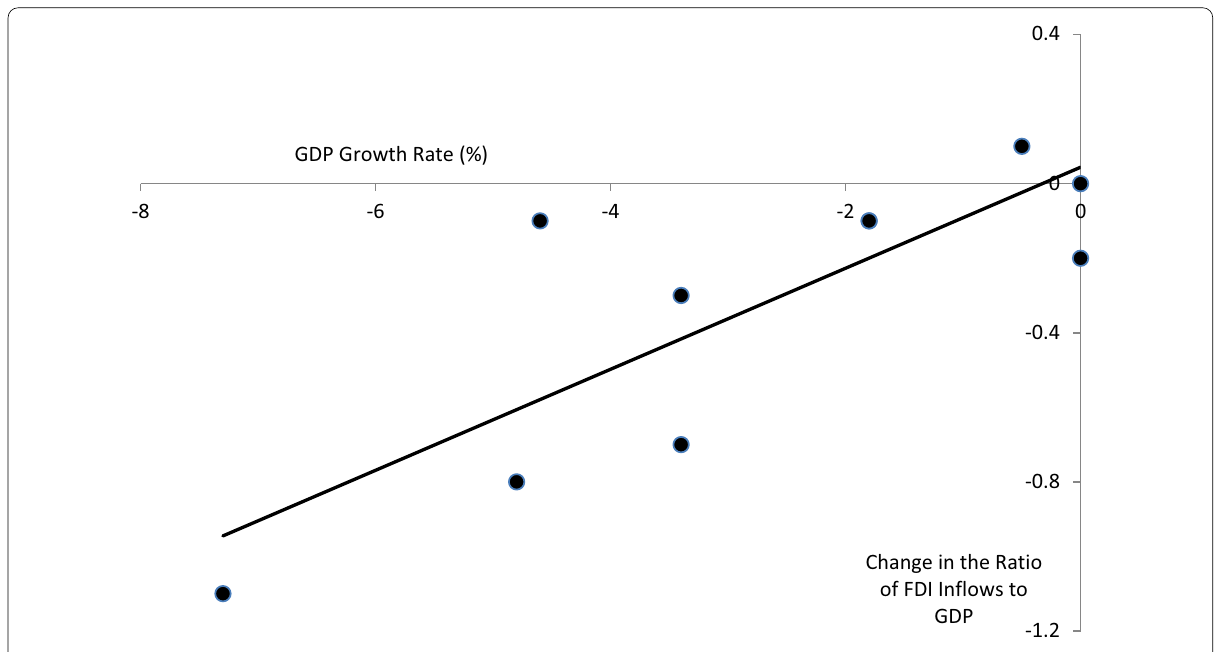
Fig. 5 Relation between GDP growth and change in the ratio of inflows to